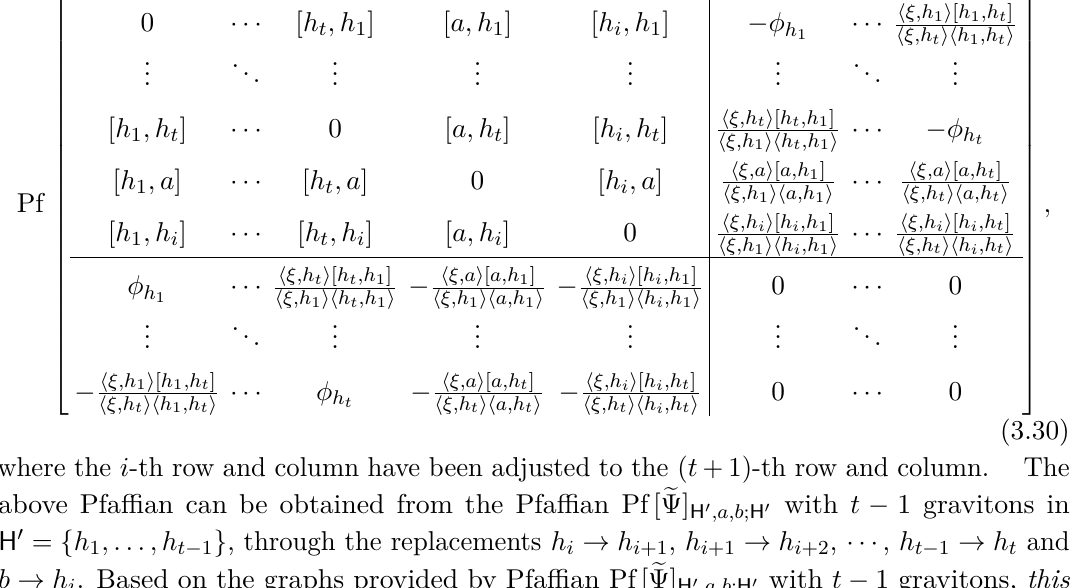
Figure 15 . Three typical graphs corresponding to the three parts, where (a): h i is directly connected to gluon b via a type-3 edge e ( b, h connected to gluon b via a type-4 edge e ( h